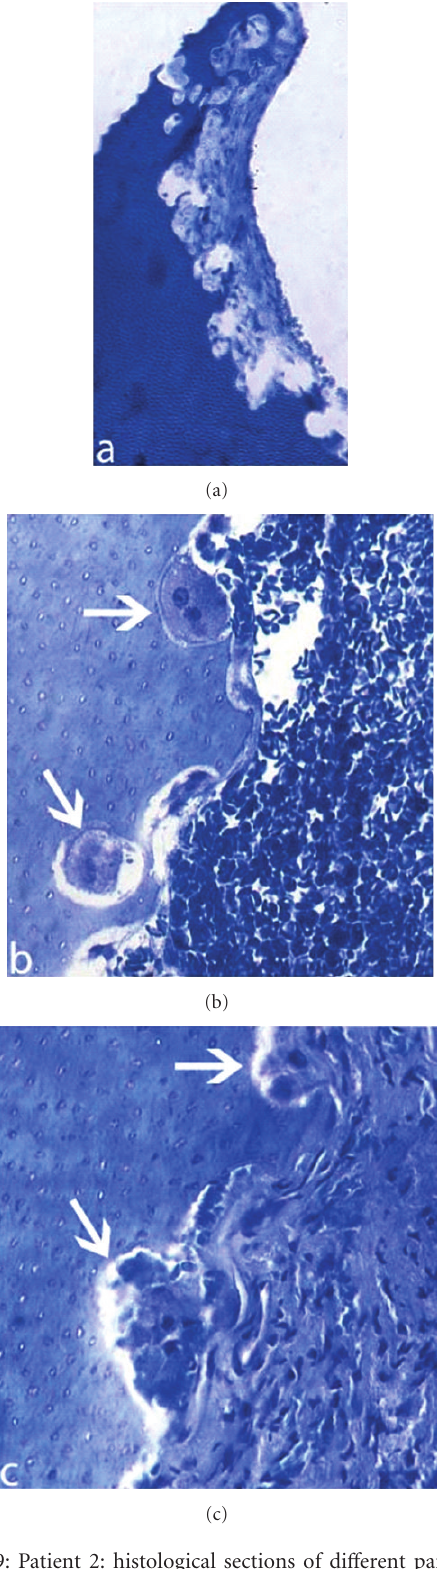
Figure 9: Patient 2: histological sections of di ff erent parts of the extracted mandibular left incisors, demonstrating aggressive multi- lacunary root surface (a). In a larger magnification, multinuclear resorptive dentinoclasts located in the lacunae are demonstrated and marked by arrows ((b) and